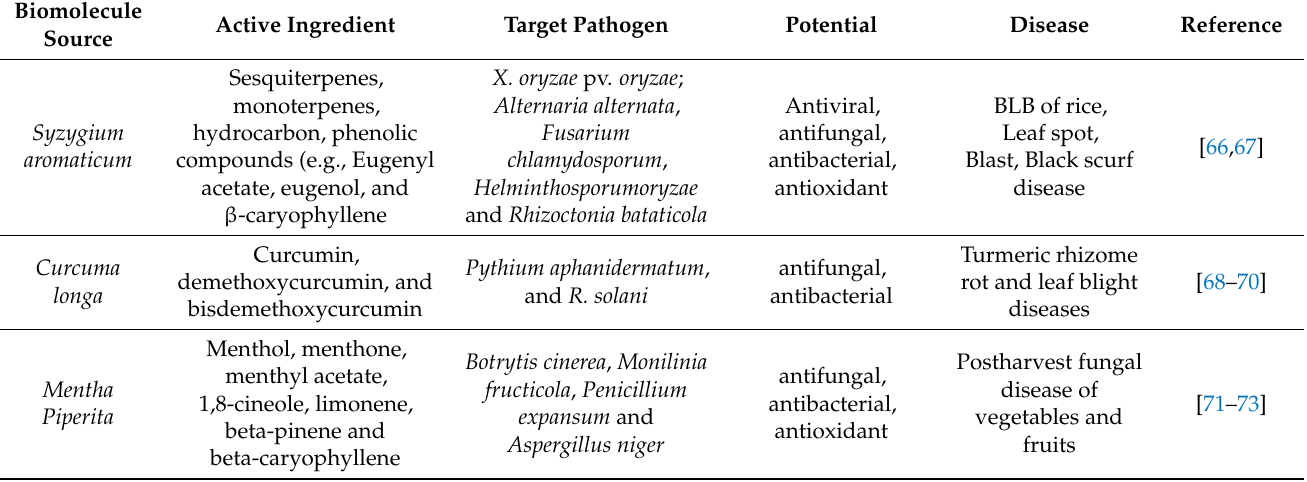
Table 4. Activity of plant biomolecules, active ingredients, their potential and target